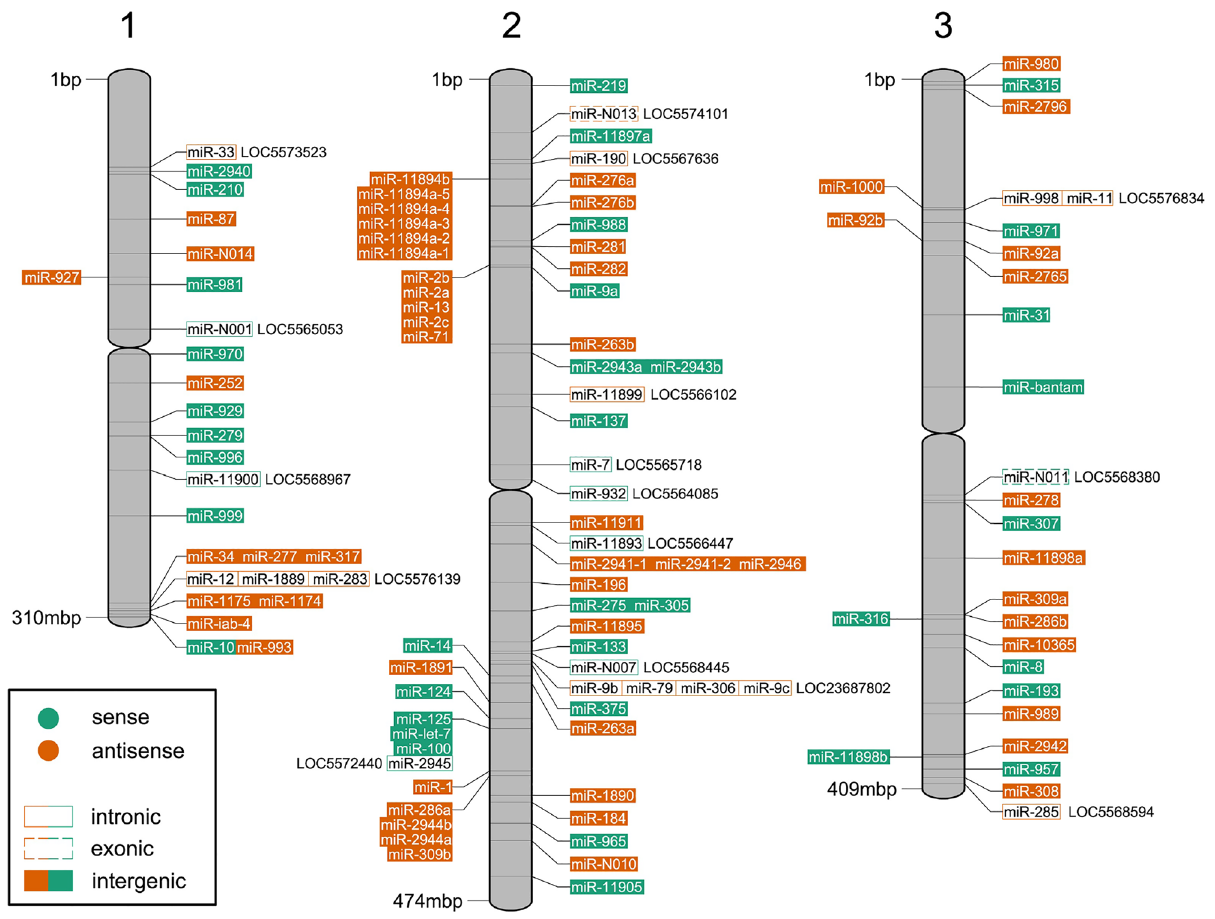
Figure 2. Position of miRNA loci on Ae. aegypti chromosomes. Map of the three Ae. aegypti chromosomes showing position, strand, and genomic context (i.e. intronic, exonic, or intergenic) of precursor miRNA loci. Gene identifiers with ‘LOC’ prefix indicate parent genes of intronic or exonic miRNA miRNAs, five were significantly upregulated with age (ANOVA, p < 0.05) (Fig. 5B). miR-2941-1-3p and 2940-5p were both significantly different between lines, while 2946-3p and 2940-5p both indicated a significant interaction between age and line (ANOVA, p < 0.05) (Fig. 5B). All miRNAs were initially lower in WB2 than in WB2.tet, but increased at a greater rate to become even with or higher than WB2.tet (Fig. 5B). miR-2940 showed differential expression with age in WB2 mosquitoes, but not in WB2.tet (Fig. 5B). Target prediction of differentially expressed miRNAs. To determine if the expression of the pre- dicted targets of the differentially expressed miRNAs could be affected by age, we selected three highly confident targets of aae-miR-317-3p and aae-miR-2946-3p (Table 3). RNA extracted from WB2 and WB2.tet mosquitoes collected at 2, 6, and 12 dpe was subjected to RT-qPCR. aae-miR-317-3p and aae-miR-2946-3p were upregulated in mosquitoes with age. RT-qPCR results revealed differential expression of most of the predicted target genes of the two miRNAs with age (ANOVA, p < 0.05) (Fig. 6). For the targets of 317-3p, AAEL010793 and AAEL010508 were significantly downregulated at 6 and 12 dpe compared to 2 dpe, while the transcript levels of AAEL006171 steadily increased over time (Fig. 6). For 2946-3p targets, AAEL006095 did not change over time, AAEL006113 declined at 6 dpe but increased at 12 dpe, and AAEL003402 significantly increased at 6 dpe but returned to the